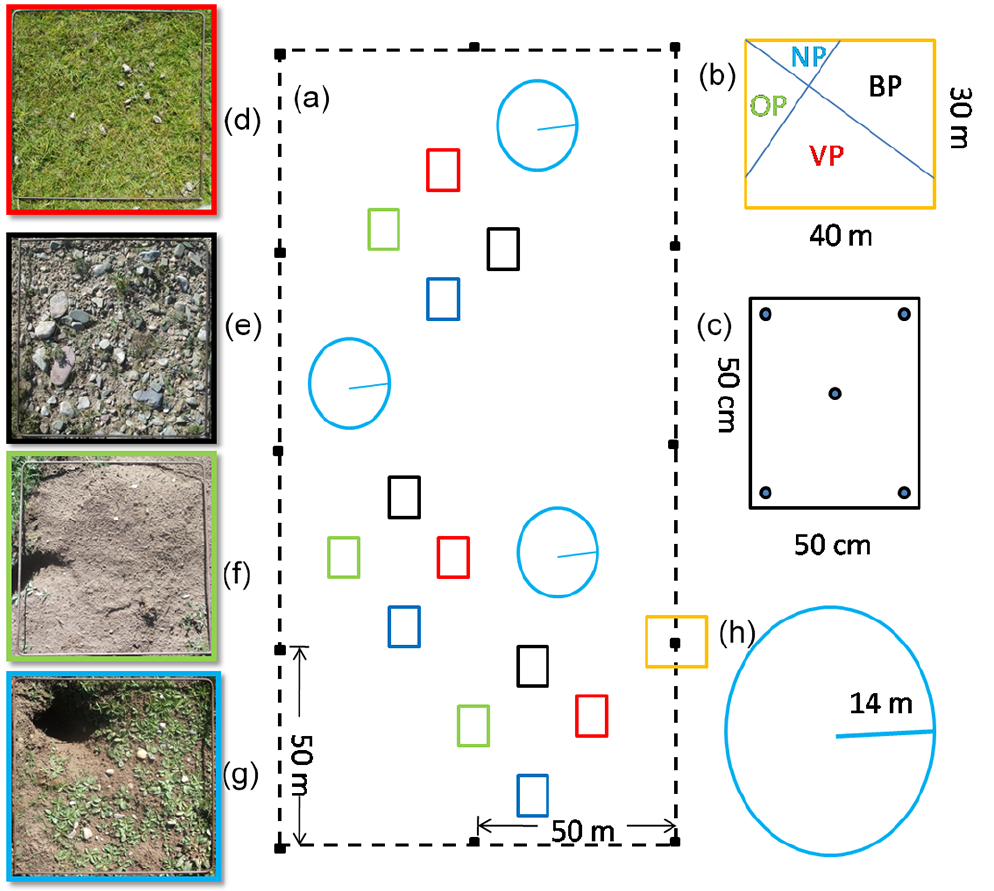
Figure 3. (a) Diagram of ground samples and aerial photographs; (b) aerial photograph on one of 12 way points (solid black rectangles in a ), each photo covers ∼ 35m by 26m of ground area and was analyzed to have four parts, i.e., VP (vegetation patch), BP (bald patch), NP (new pika pile), and OP (old pika pile); (c) ground sample quadrat with 50cm by 50cm for vegetation cover, soil carbon, and nitrogen (open rectangles in a ) with red for vegetation patch (d) , black for bald patch (e) , green for new pika pile (f) , and blue for old pika pile ( g ); and (h) a circular plot with a radius of 14m for counting pika piles and